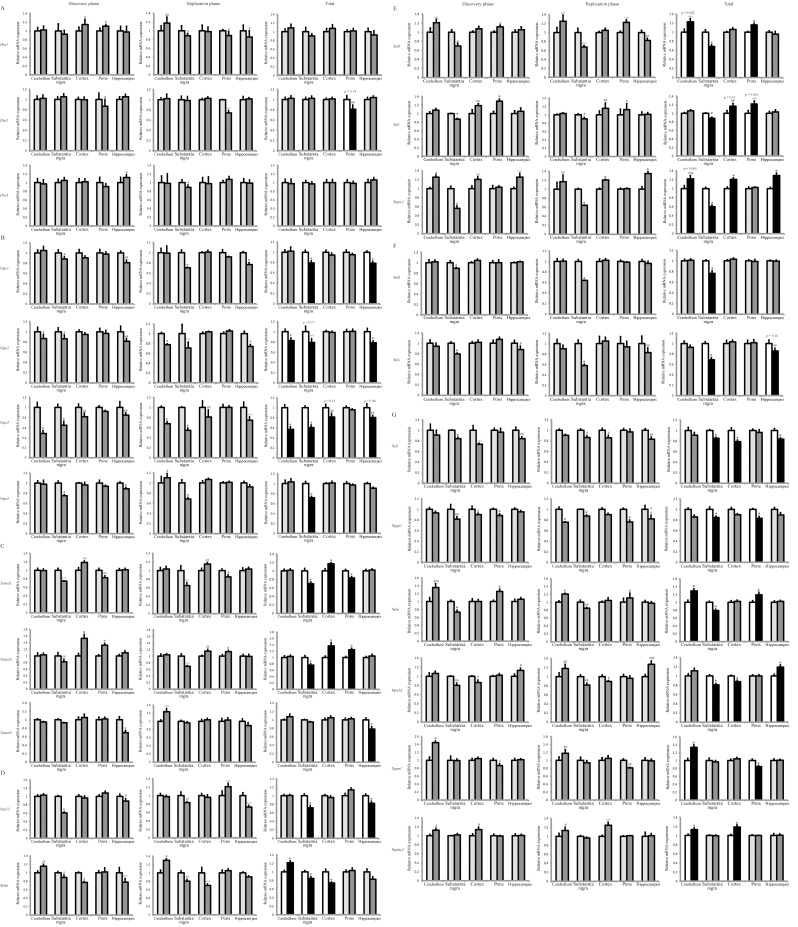
Two-phase mapping of selenotranscriptome in the cerebellum, substantia nigra, cortex, pons and hippocampus of control and PD mice.The selenotranscriptome is categorized as iodothyronine deiodinases (A), glutathione peroxidases (B), thioredoxin reductases (C), thioredoxin-like endoplasmic reticulum proteins (D), the Rdx family members (E), SelK and SelS (F), and others (G). The black and white bars indicate those with repeatability in the discovery and replication phases. *, p < 0.05, compared to control. #, ##, and ### indicates a trend of difference with percentage of change at 10–15%, 15–20%, and > 20% respectively. The left and right bars for each of the sub-brain regions denote control and PD mice, respectively.